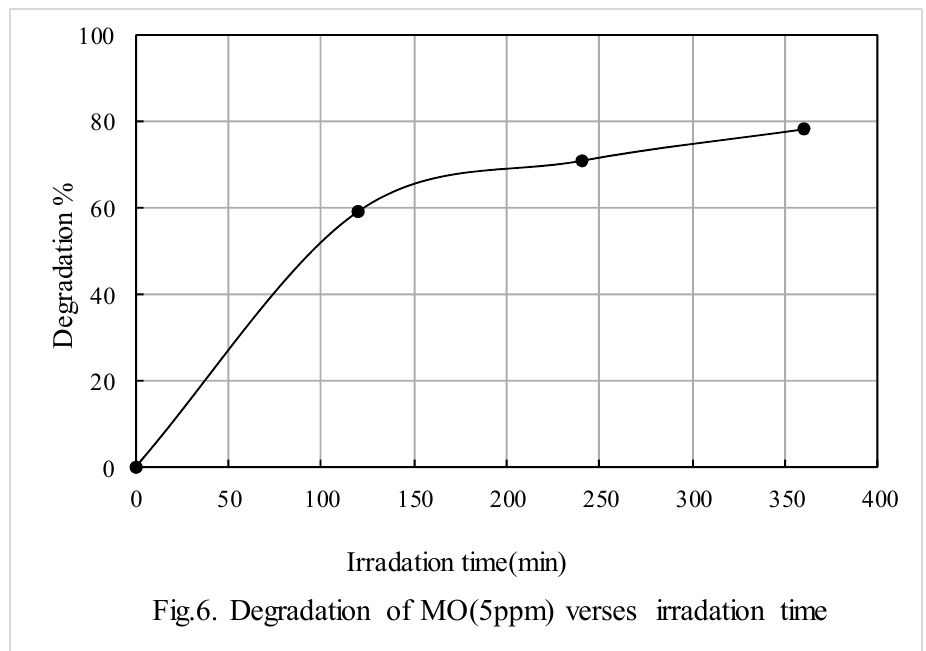
Fig.6. Degradation of MO(5ppm) verses irradation time